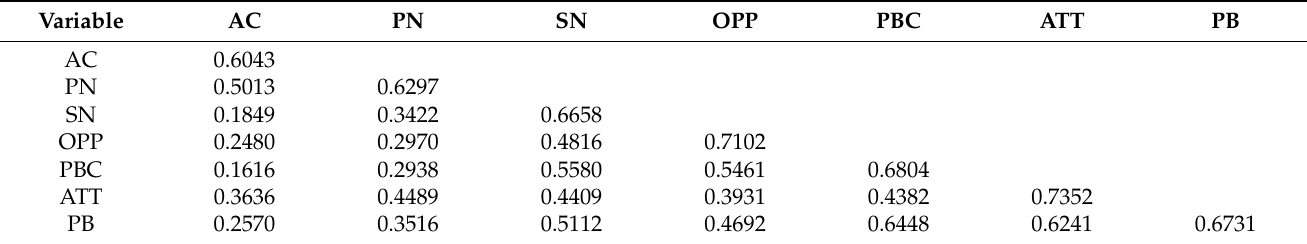
Table 4. Convergent and discriminant